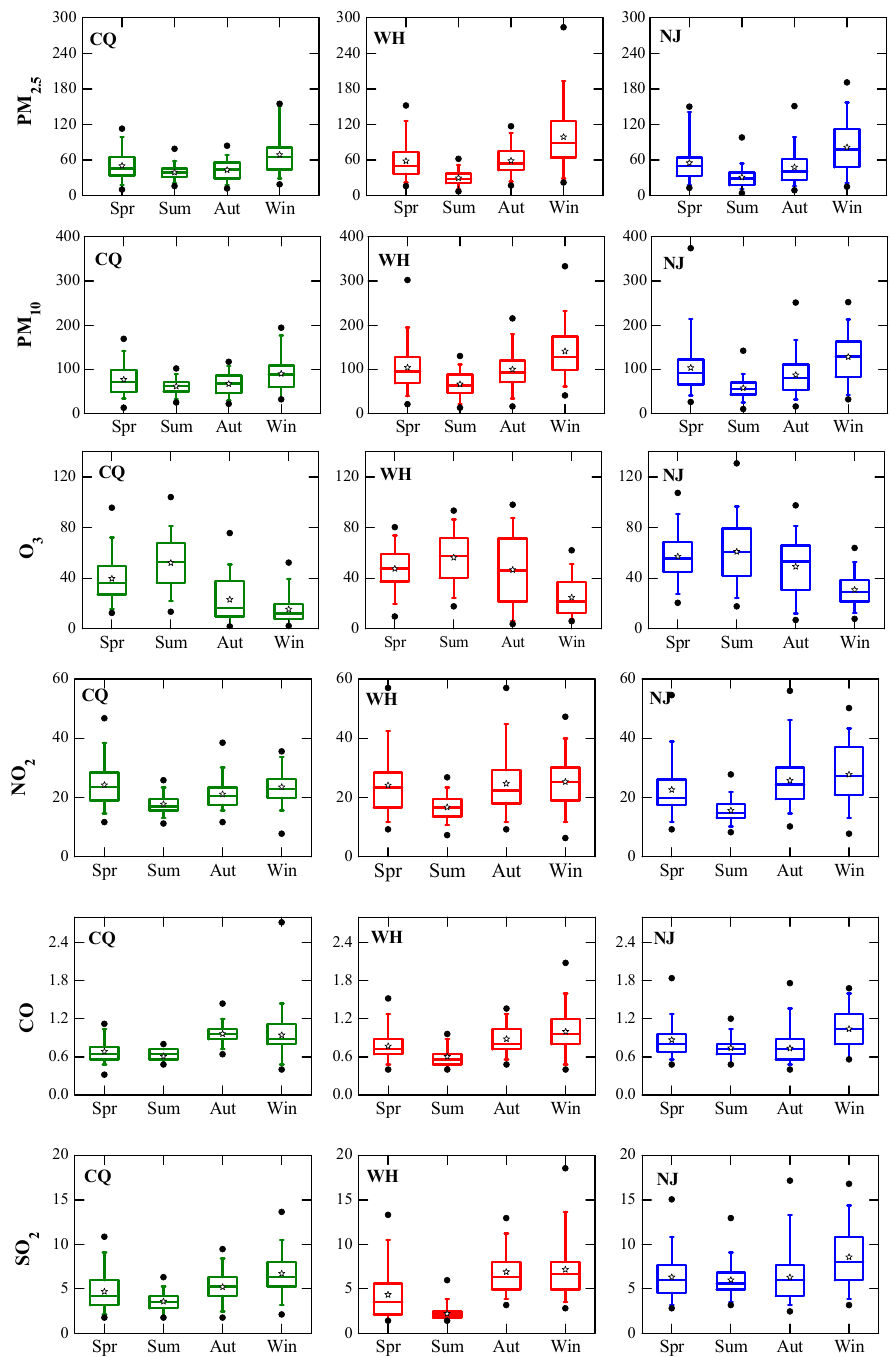
Figure 4. Whiskers box-plots with the concentrations of six air pollutants according to their respective seasons (units are µ g/mg 3 for PM 2.5 and PM 10 , ppb for O 3 -8 h, NO 2 and SO 2 , and ppm for CO). The top and bottom whiskers show the 95th and 5th percentile while the upper and lower boundaries of the central box show 75th and 25th percentile. The middle line of the box represents median, pentacle represents the arithmetic average and circle represents max and min values.